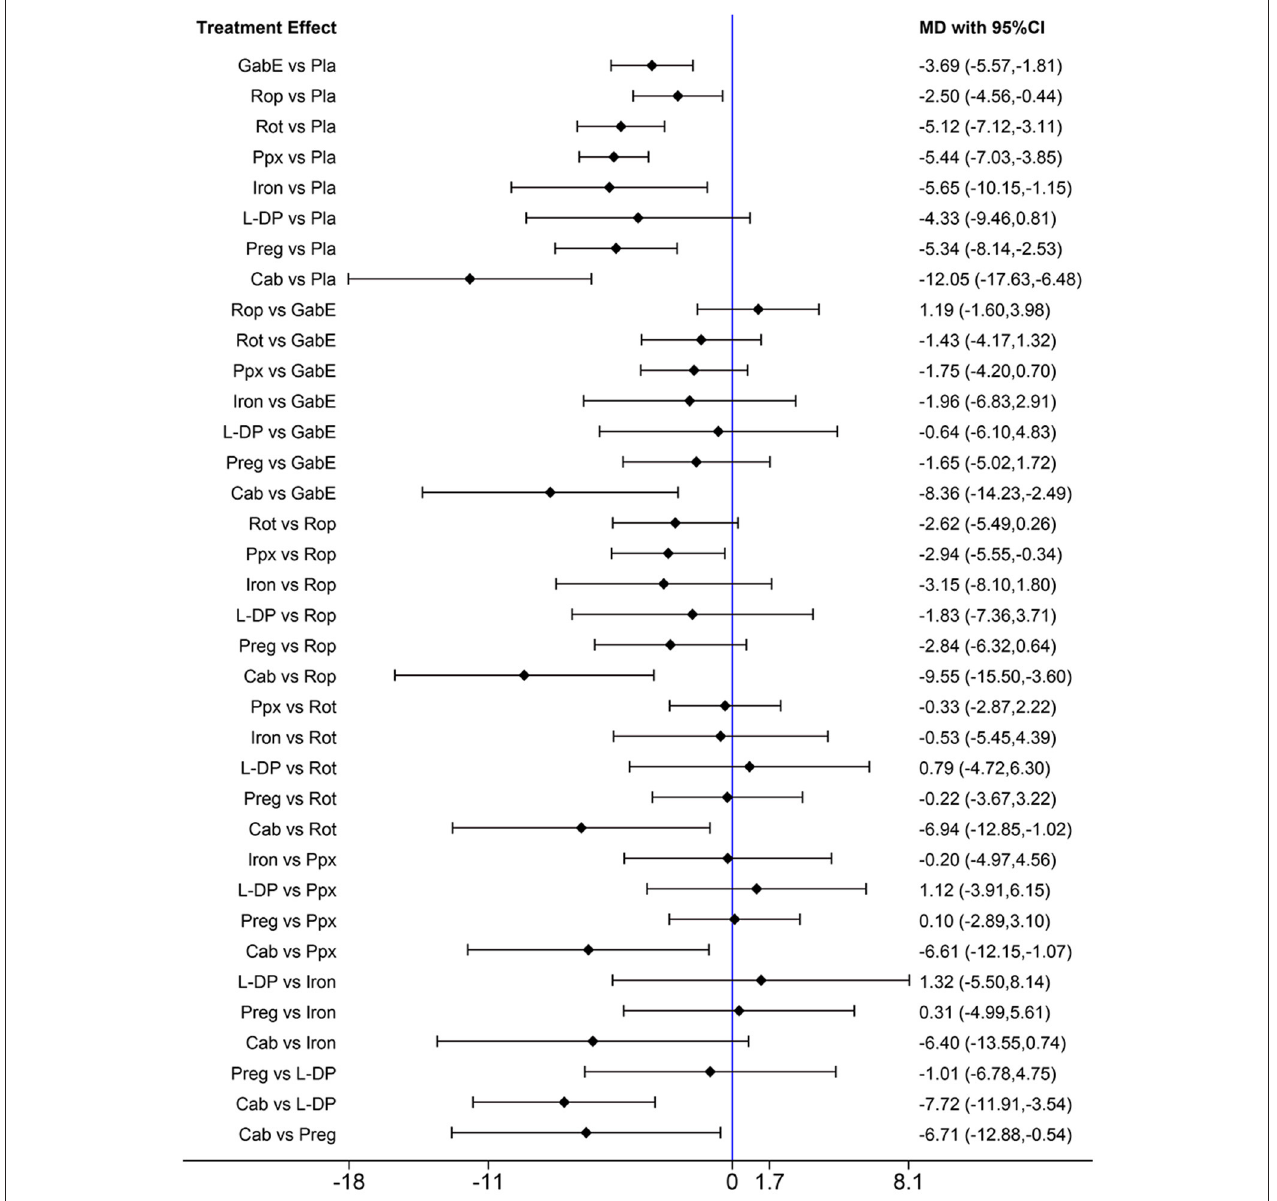
FIGURE 7 | Forest plots of pairwise meta-analysis for different drugs in treatment of primary RLS patients. (Gab, Gabapentin; GabE, Gabapentin enacarbil; L-DP, Levodopa; Rot, Rotigotine; Ppx, Pramipexole; Cab, Cabergoline; Rop, Ropinirole; Preg, Pregabalin; Oxy-Na, Oxycodone-naloxone; Pla, Placebo).